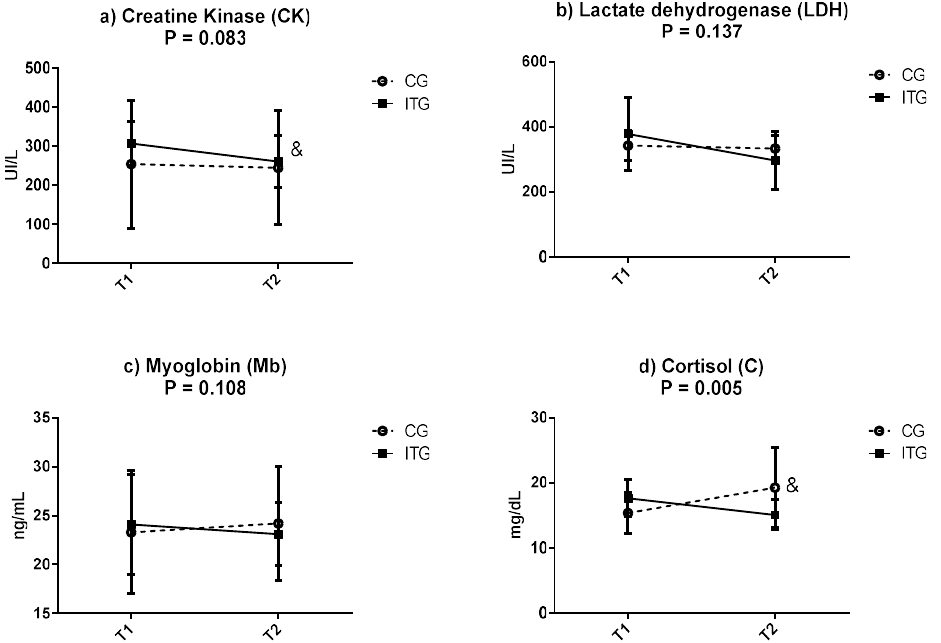
Figure 2. Concentrations of ( a ) creatine kinase (CK), ( b ) lactate dehydrogenase (LDH), ( c ) myoglobin (Mb) and ( d ) cortisol (C) in the control group (CG) and in the iron treated group (ITG) at the beginning (T1) and at the end of intervention (T2). Data are expressed as mean ± standard deviation. P: group-